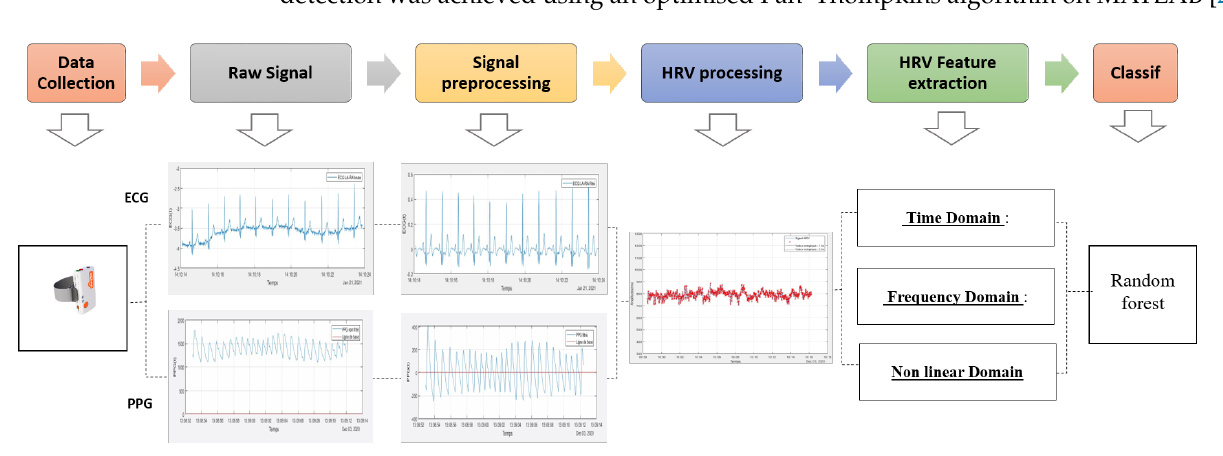
Figure 1. Overview of processing steps from data collection to HRV feature extraction and classifica- tion. Each of these steps is detailed in Section